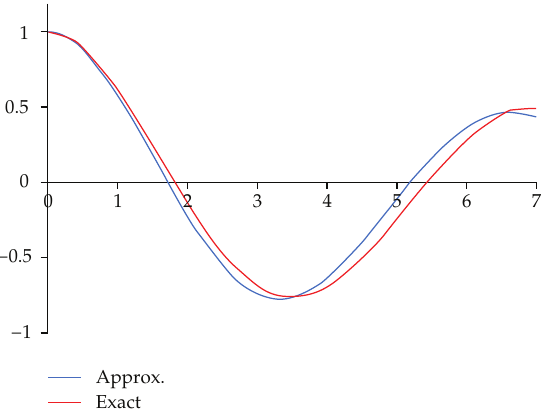
Figure 3: A comparison between the analytical solution and our approximated solution for k (cid:8) 1 / 5.